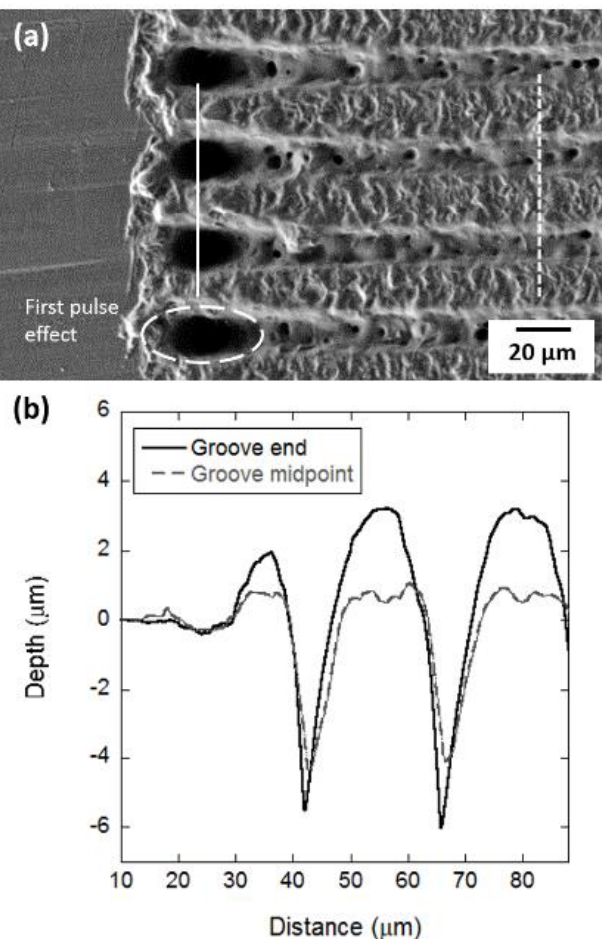
Figure 6. SEM image of grooves created by picosecond pulsed laser ablation; ( a ) line profiles across the grooves: at the end of the trenches (continuous line) and at the midpoint of the trenches (dashed line) ( b ).